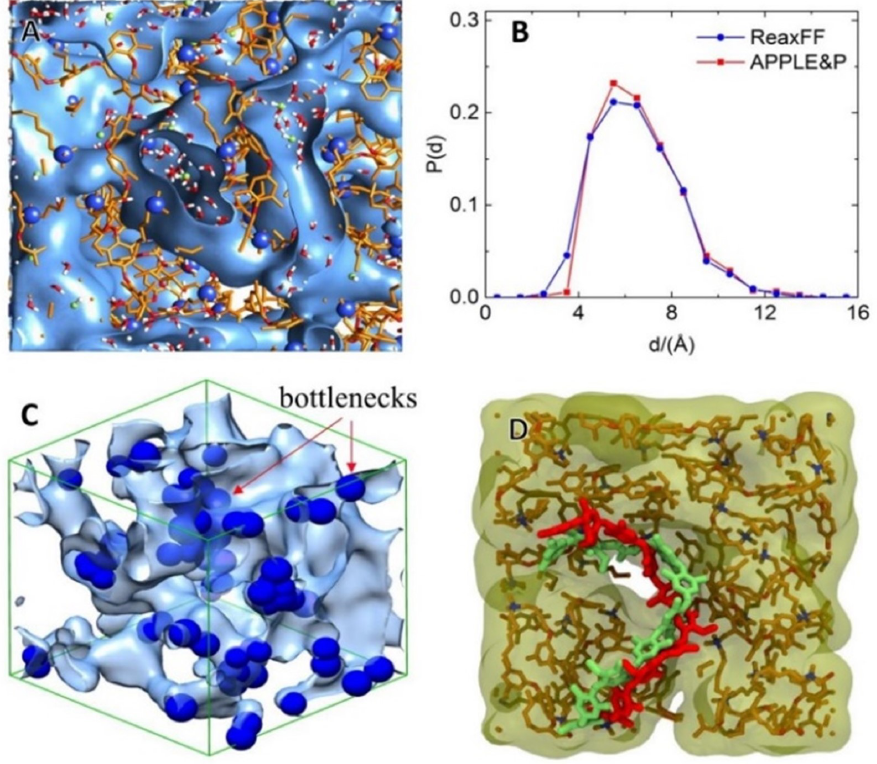
Figure 9. ( A ) Snapshot of hydrated M1 membrane with water channels illustrated by isosurfaces, corresponding to 50% of bulk water density. ( B ) Distribution of water channel width. ( C ) Blue spheres illustrate the locations of the “bottlenecks” inside water channels. ( D ) Illustration of correspondence of membrane morphologies obtained from the APPLE&P simulation and mapped to ReaxFF. The red chain shows a polymer backbone for the selected chain in the APPLE&P simulation, while the green chain shows the same chain after mapping and relaxation in ReaxFF simulation. Reprinted with permissions from [36]. Copyright 2020, for the American Chemical